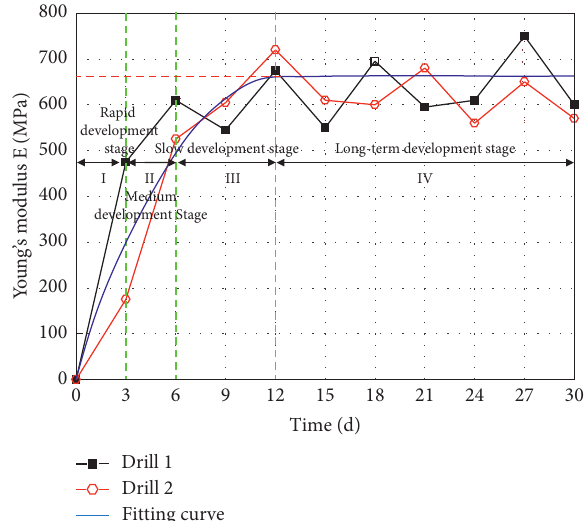
Figure 8: Development of Young’s modulus with the underground curing time.